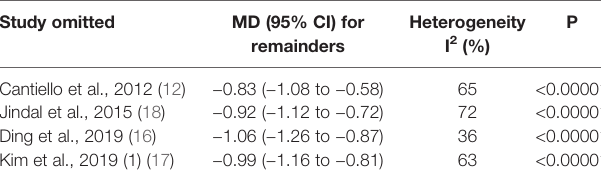
TABLE 3 | Sensitivity analysis of 12-cores prostate biopsy after each study was excluded by